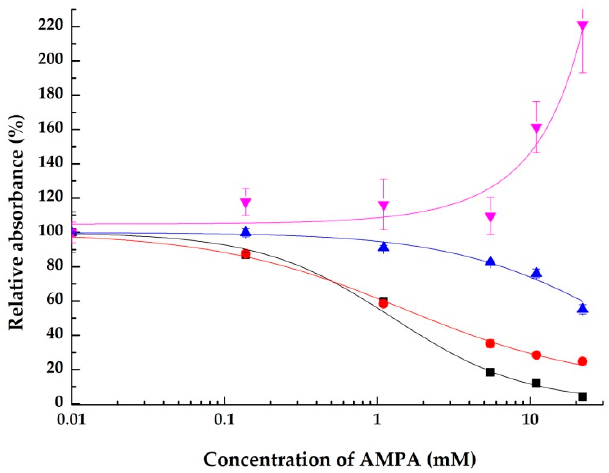
Figure 5. Concentration-dependent inhibitory effects of AMPA on the integrins α V β 3 using RGD (black), α 5 β 1 using RGD (blue), α V β 3 using vitronectin (red) and α llb β 3 using fibrinogen (pink). Data are shown as means ± SD.